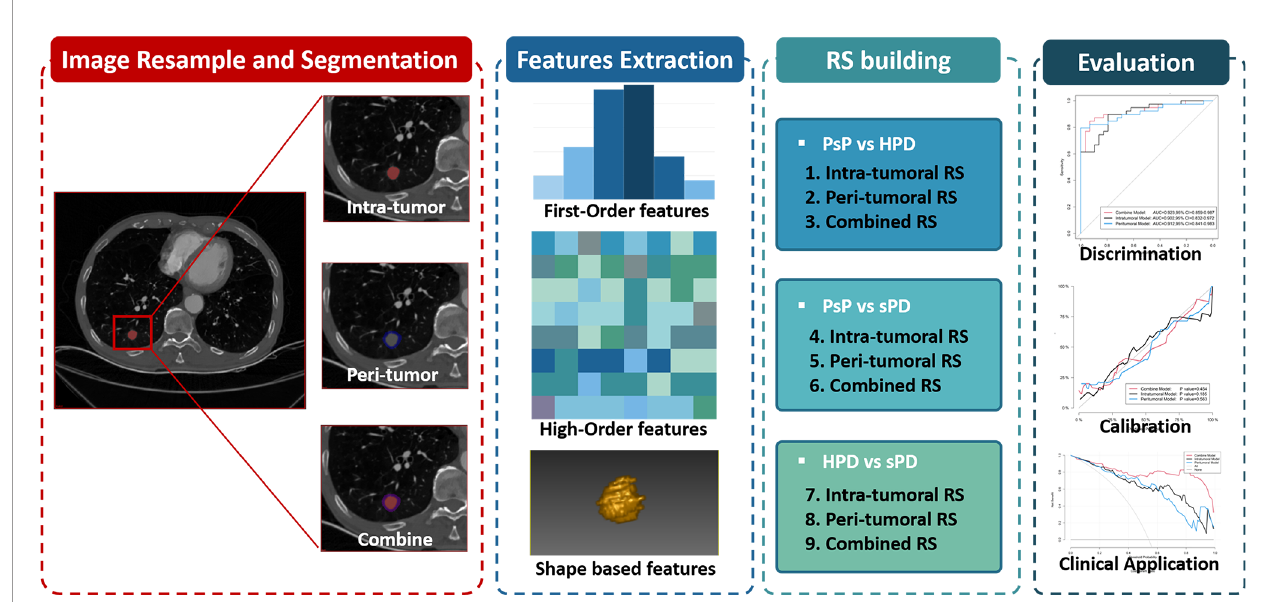
FIGURE 3 | The radiomics work fl ow including tumor segmentation, feature extraction, radiomics signatures construction, and performance